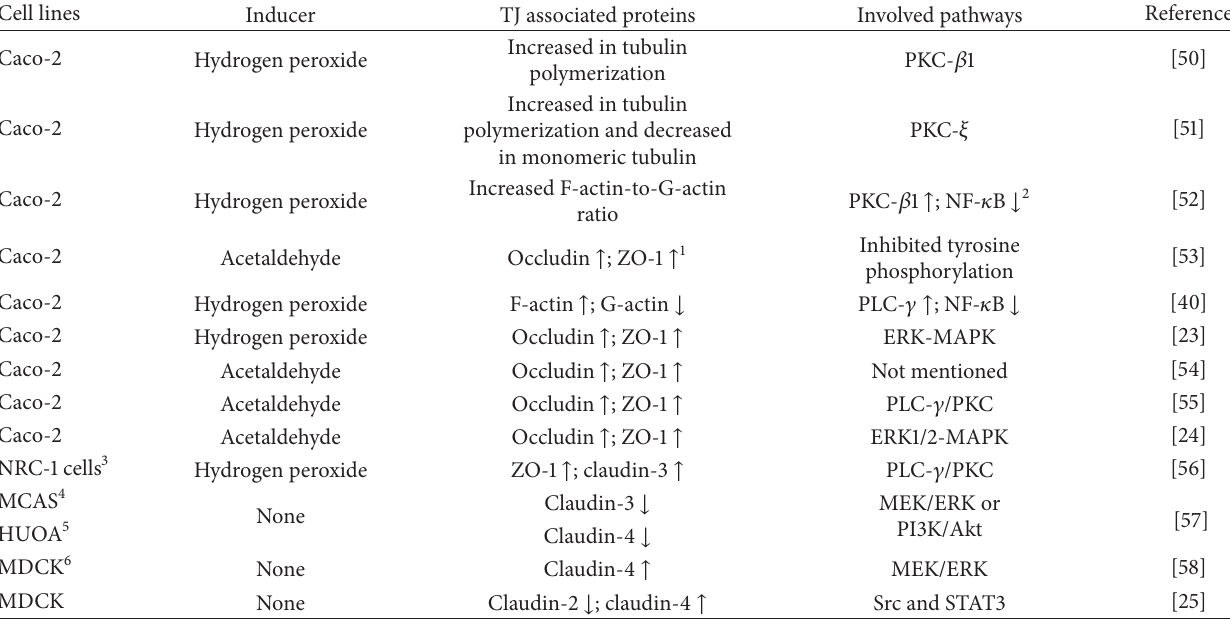
Table 2: The effects of EGF on EGF-mediated protection of tight